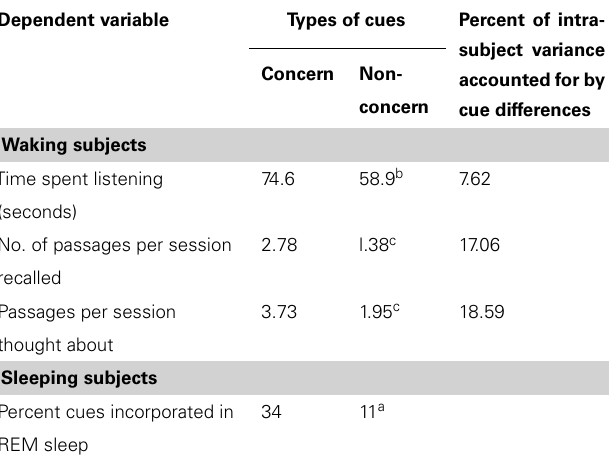
Table 1 | Cognitive responsiveness to concern-related versus non-concern-related